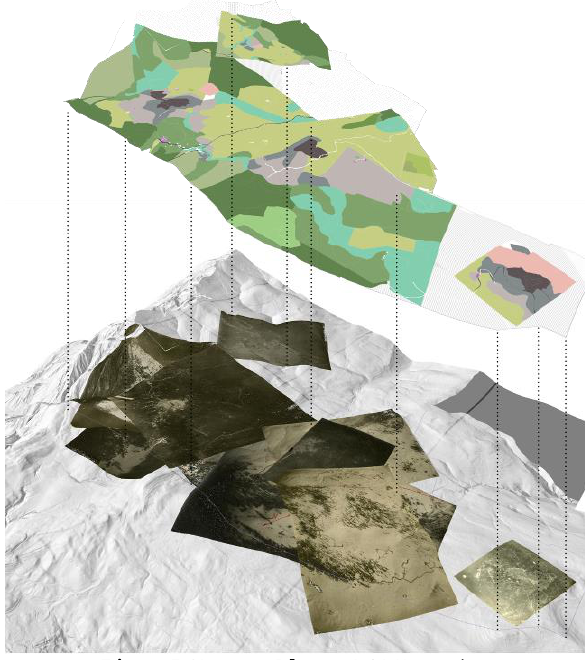
Figure 5 . Vezzena Plateau: LCLU wartime